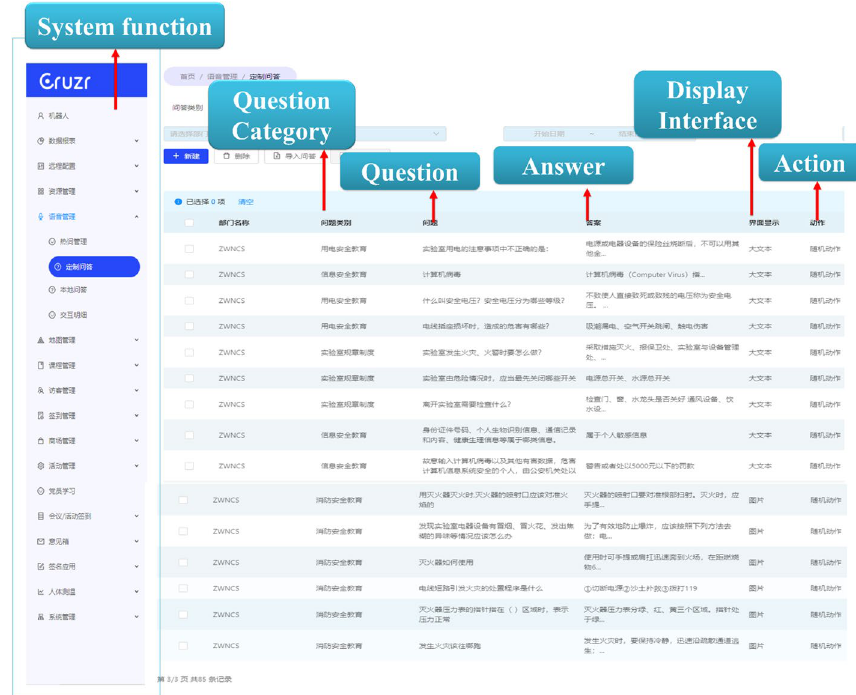
Fig. 2 AIER interactive system development interface